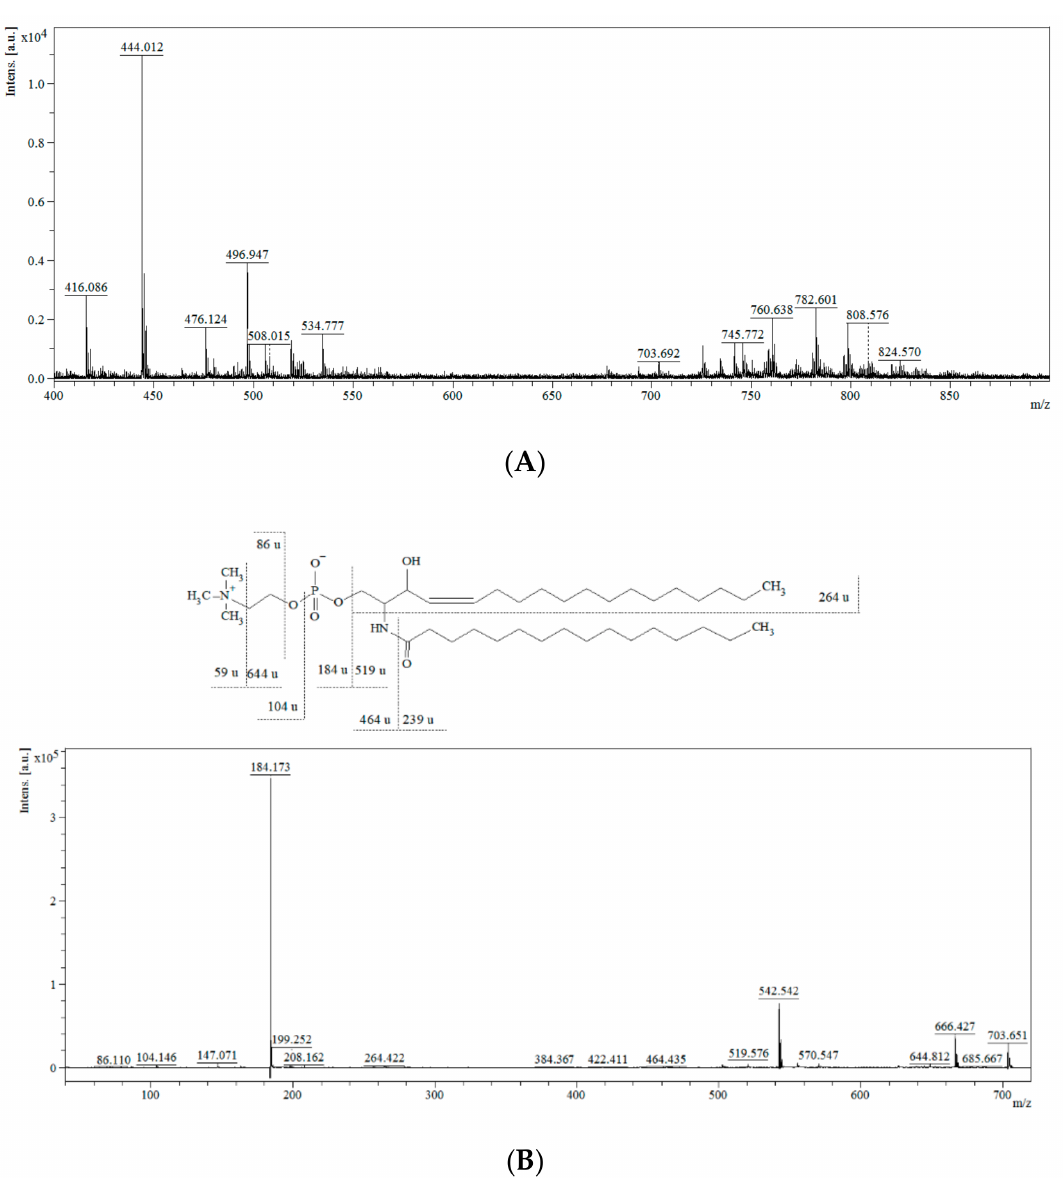
Figure 1. Mass spectra of the lipidomic profile obtained from MALDI-ToF/MS in positive ion mode ( A ) and MS/MS spectra and fragmentation pathway of SM (d18:1/16:0) m / z 703.651 ( B ). PS was identified in the negative ion mode. The ions at m / z 700.95 and 603.05 resulted from the neutral losses of a serine head group [C 3 H 5 NO 2 ] − (87.0 u) and phosphoserine moiety [C 3 H 8 NPO 6 ] − (185.2 u), respectively. The peak at m / z 281.40 corresponds to the neutral loss of oleic acid (C18:1). The fragment detected at m / z 504.05 corresponds to the loss of stearic acid [M-R 1 COOH] − . The ion at m / z 419.55 probably resulted from the neutral loss of oleic acid with a serine head